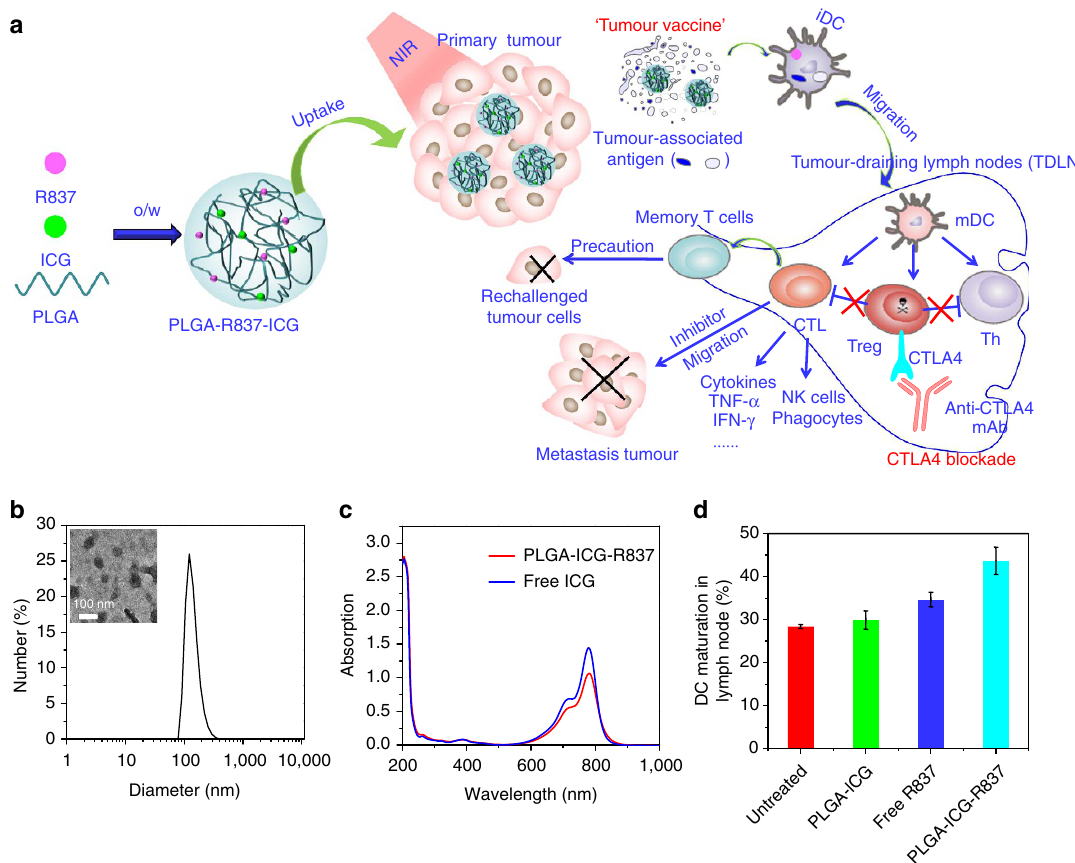
Figure 1 | Formulation of nanoparticles and their immune-stimulation abilities. ( a ) The mechanism of anti-tumour immune responses induced by PLGA-ICG-R837-based PTT in combination with checkpoint-blockade. ( b ) Hydrodynamic diameters of PLGA-ICG-R837 nanoparticles measured by DLS. Inset: ( a ) TEM image of PLGA-ICG-R837. ( c ) UV–vis–NIR spectra of PLGA-ICG-R837 and free ICG, indicating the successful loading of ICG into PLGA. ( d ) In vivo DC maturation (CD80 þ CD86 þ ) with lymph nodes of BALB/c mice s.c. injected with PLGA-ICG, free R837, or PLGA-ICG-R837 (three mice per group). Data are presented as the mean ± s.e.m. Error bars are based on triplicated experiments. DLS, dynamic light scattering; TEM, transmission electron